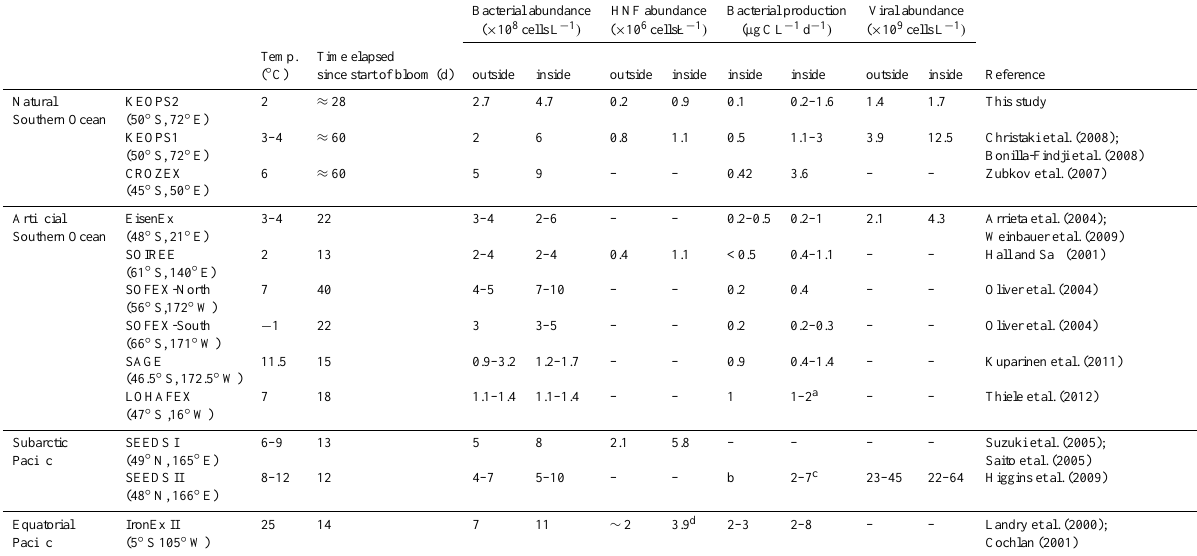
Table 7. Comparison of bacterial parameters following natural and artificial iron-fertilization. Ranges of bacterial abundance and production are given for the wind mixed layer of the respective study. All rates of bacterial production are derived from [ 3 H]leucine-incorporation, except for Hall and Safi (2001) who applied [ 3 H]thymidine-incorporation. Outside – values reported for HNLC waters; inside – values reported for iron-fertilized patches. –: not done, a BP values given in this paper as pM leuh − 1 were converted into µgCL − 1 d − 1 according to Kirchman (1993), b not given in the paper, c calculated from cell production based on a 23.3fgcell − 1 used by the authors, d max. value in the patch, mean value outside the patch extrapolated from Fig. 10, Landry et al.